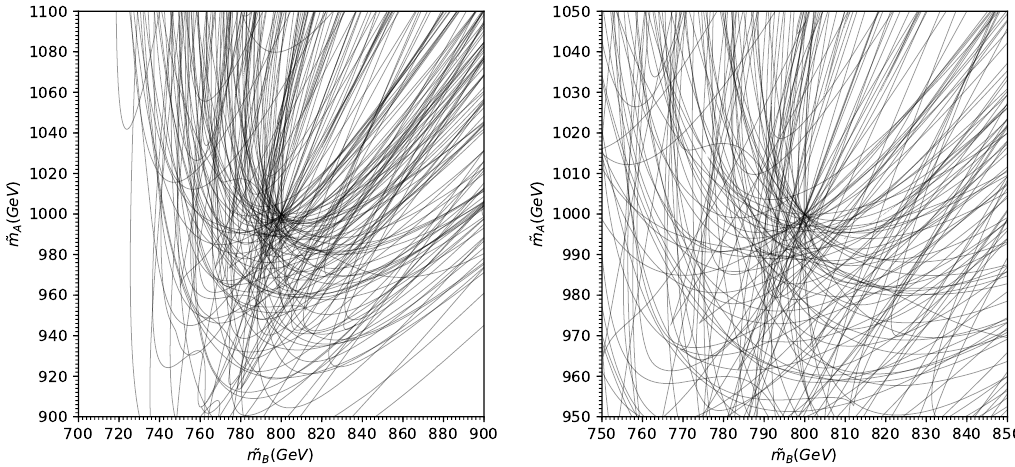
Figure 15 . The same as (cid:12)gure 14, but with 100 events and zoomed in by a factor of 5 (left panel) and a factor of 10 (right panel).